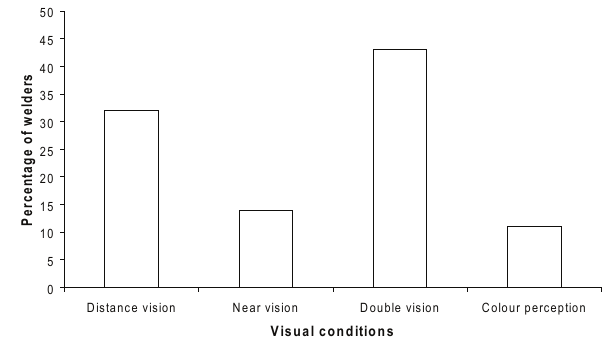
Figure 1: Reported visual conditions and percentages of the re- spondents.